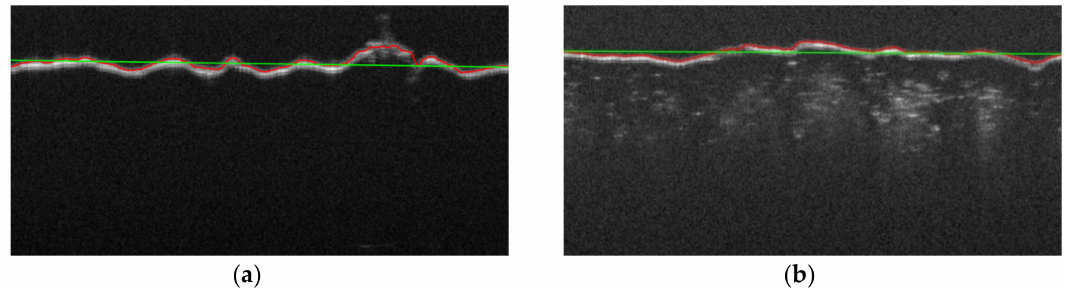
Figure 8. Example B-scan with approximated profile of base plane: ( a ) for Cordura with an Ag layer; ( b ) for Cordura without a metal